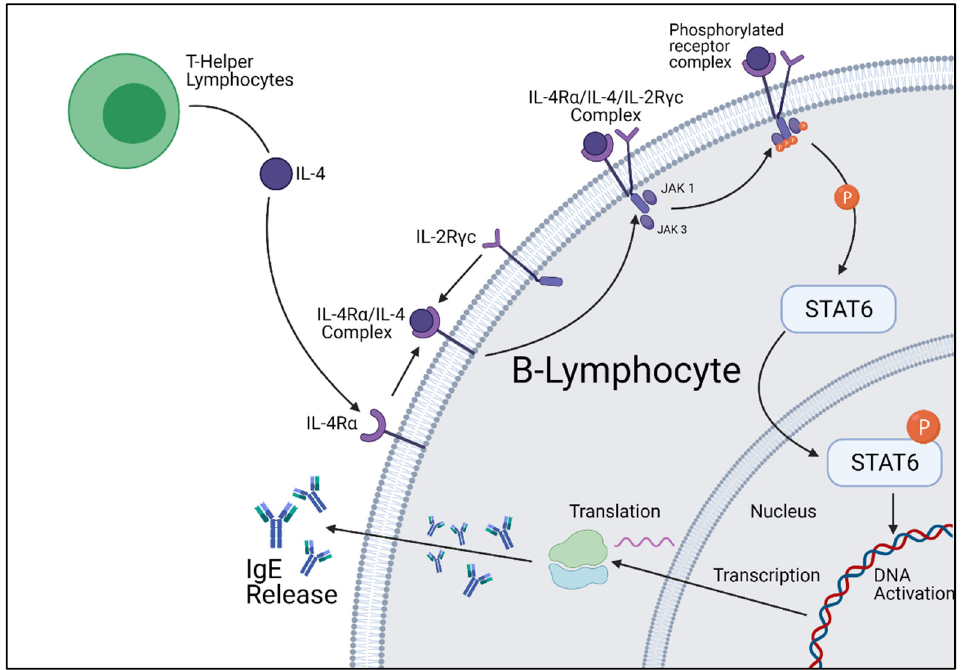
Figure 2. Cellular summary of B-lymphocyte IgE production initiated by IL-4 stimulation. Figure was created by the authors and reproduced with permission from BioRender.com (accessed on 19 November 2021).